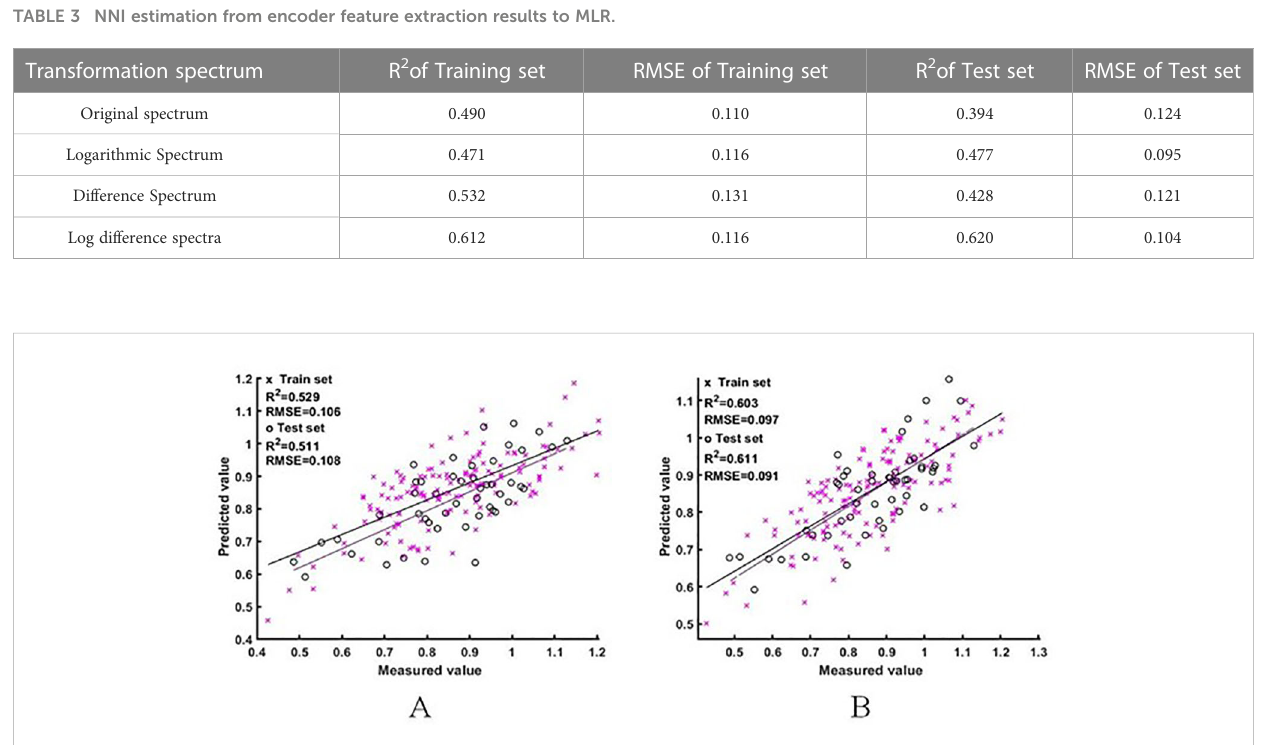
FIGURE 5 NNI estimation results based on the original spectra. ( A is the ELM model estimation result, B is the BES-ELM model estimation result).